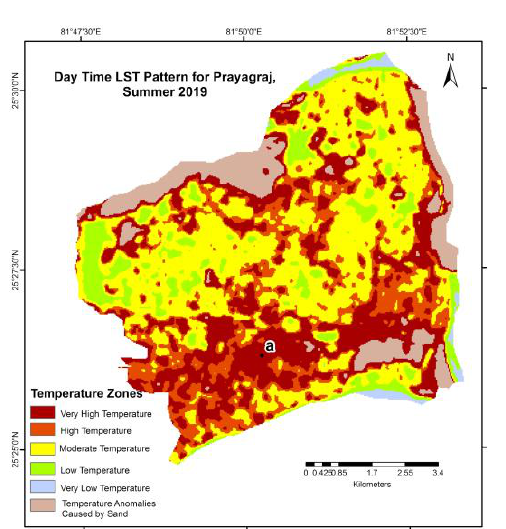
Figure 7. Day time LST and UHI of Prayagraj in summer, 2019 Prayagraj. The UHI cover increased to 10.39km 2 , covering 15.61% of the total area. The UHI I in this southern commercial area was 1.99°C.